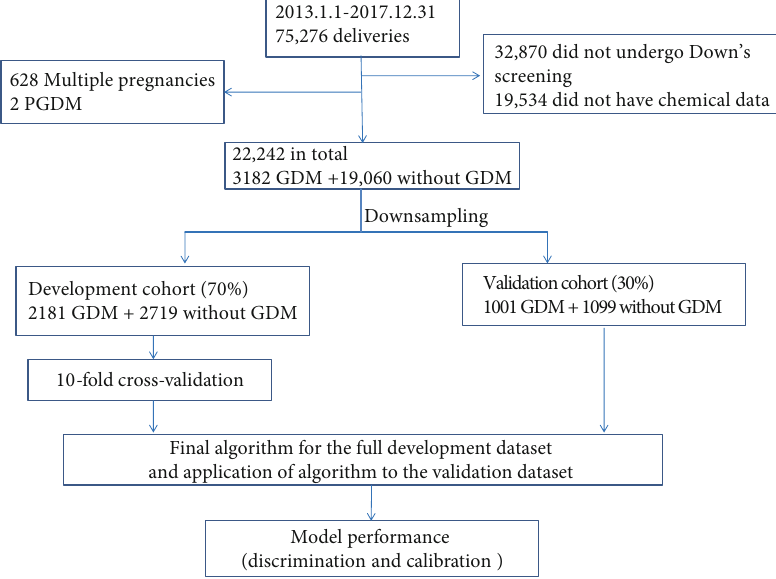
Figure 1: Study pro fi le and analysis